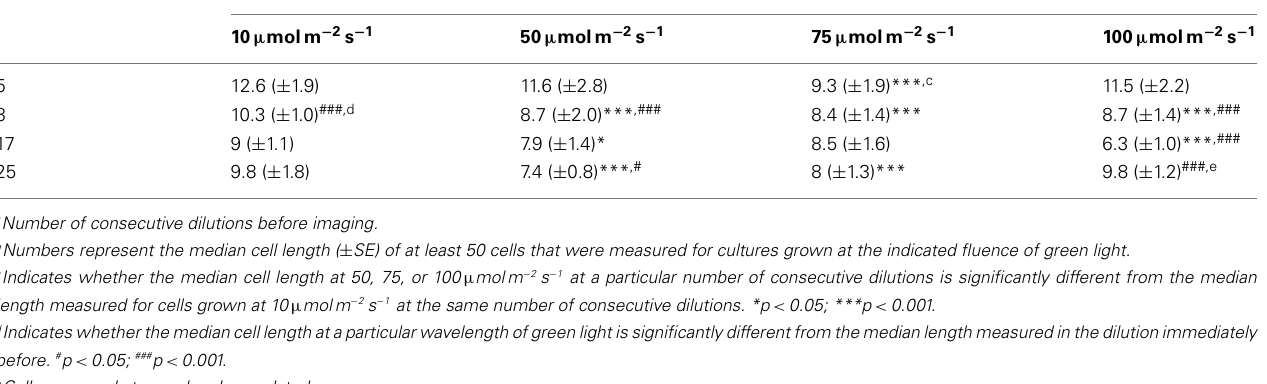
Table 1 | Median length of cells of Fremyella diplosiphon grown under varying intensities of green light. Dilutions